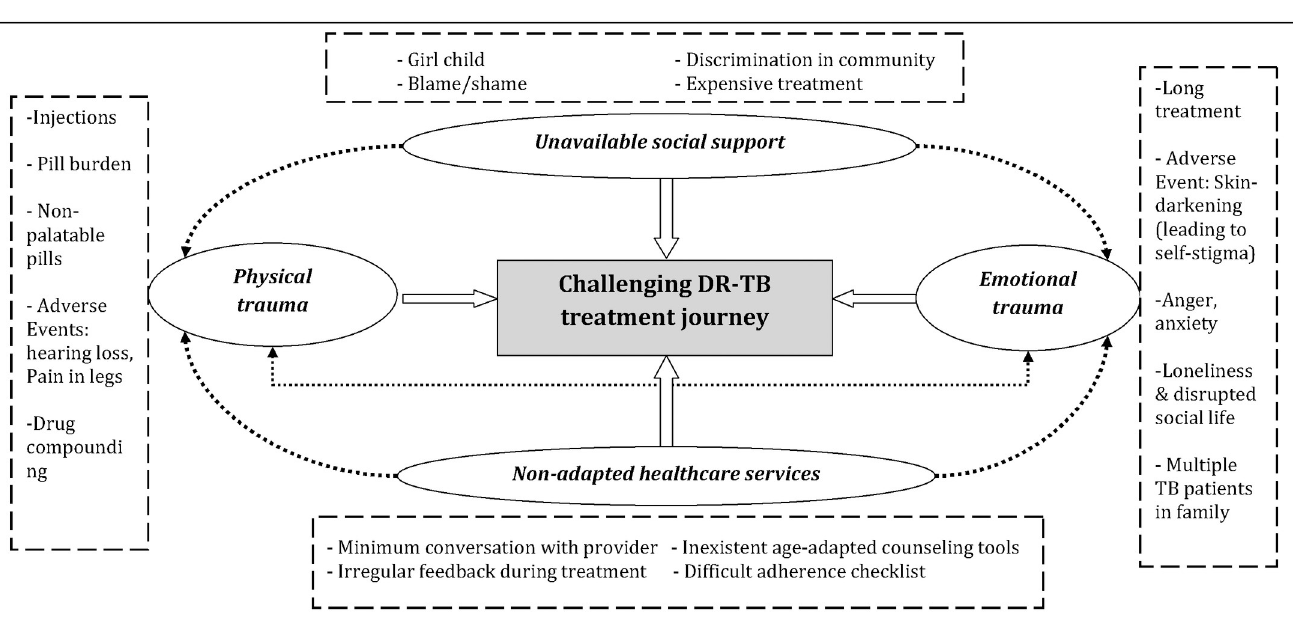
PLOS ONE | https://doi.org/10.1371/journal.pone.0248408 March 10,